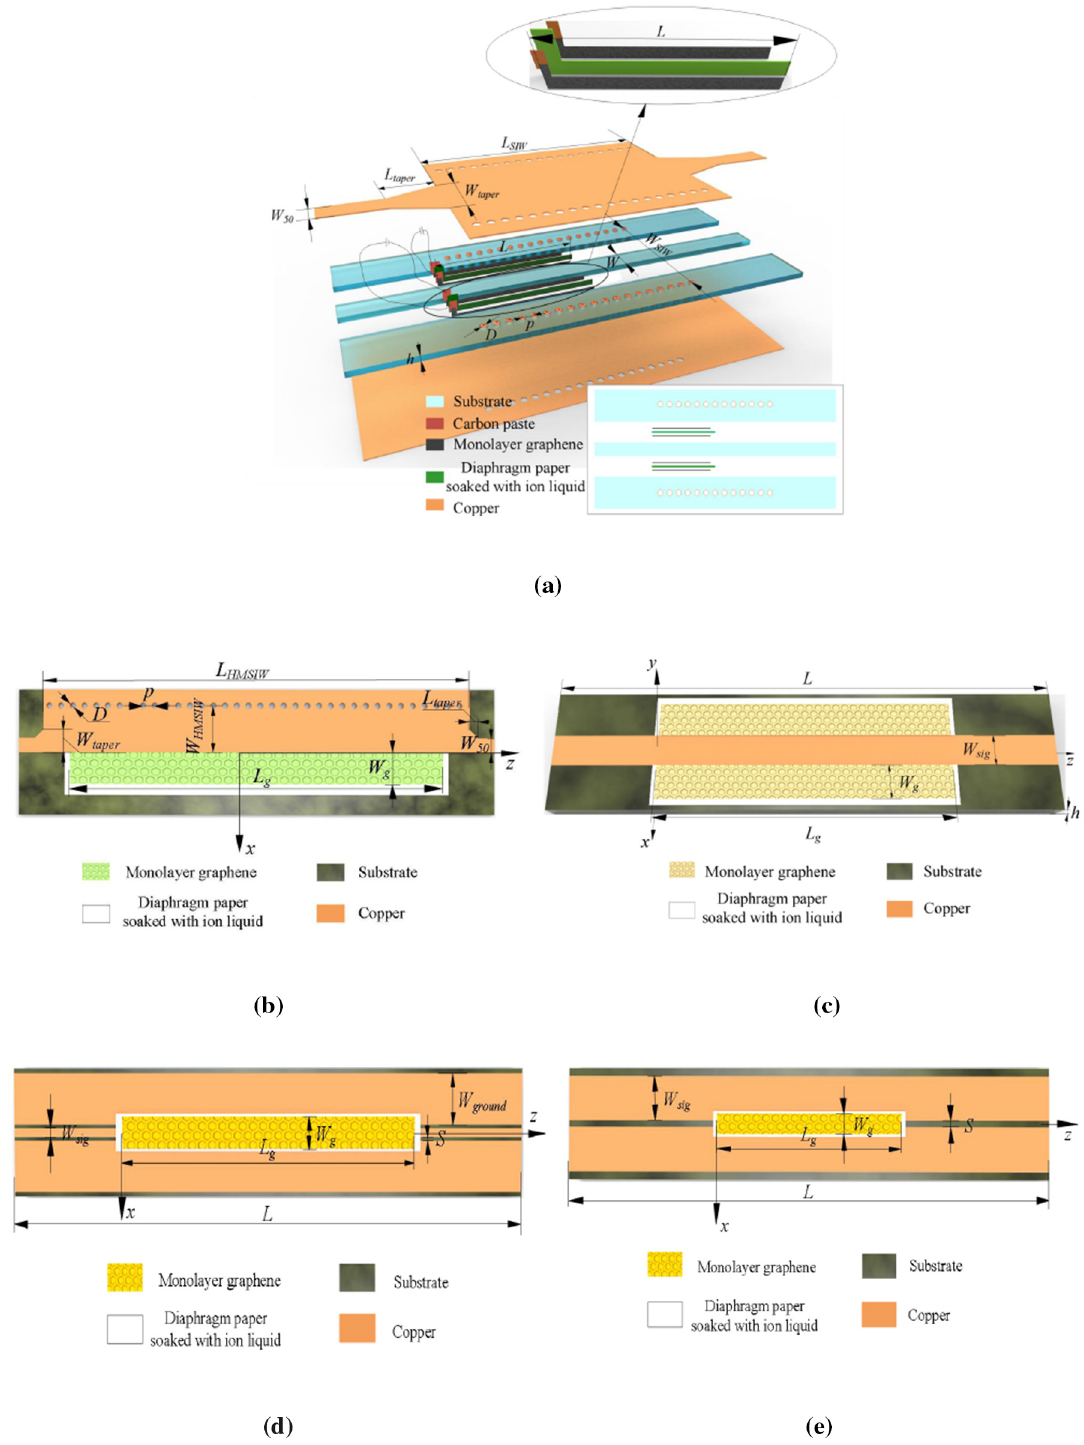
microstrip. (d) The con fi guration of CPW attenuator. (e) The con fi guration of slot line